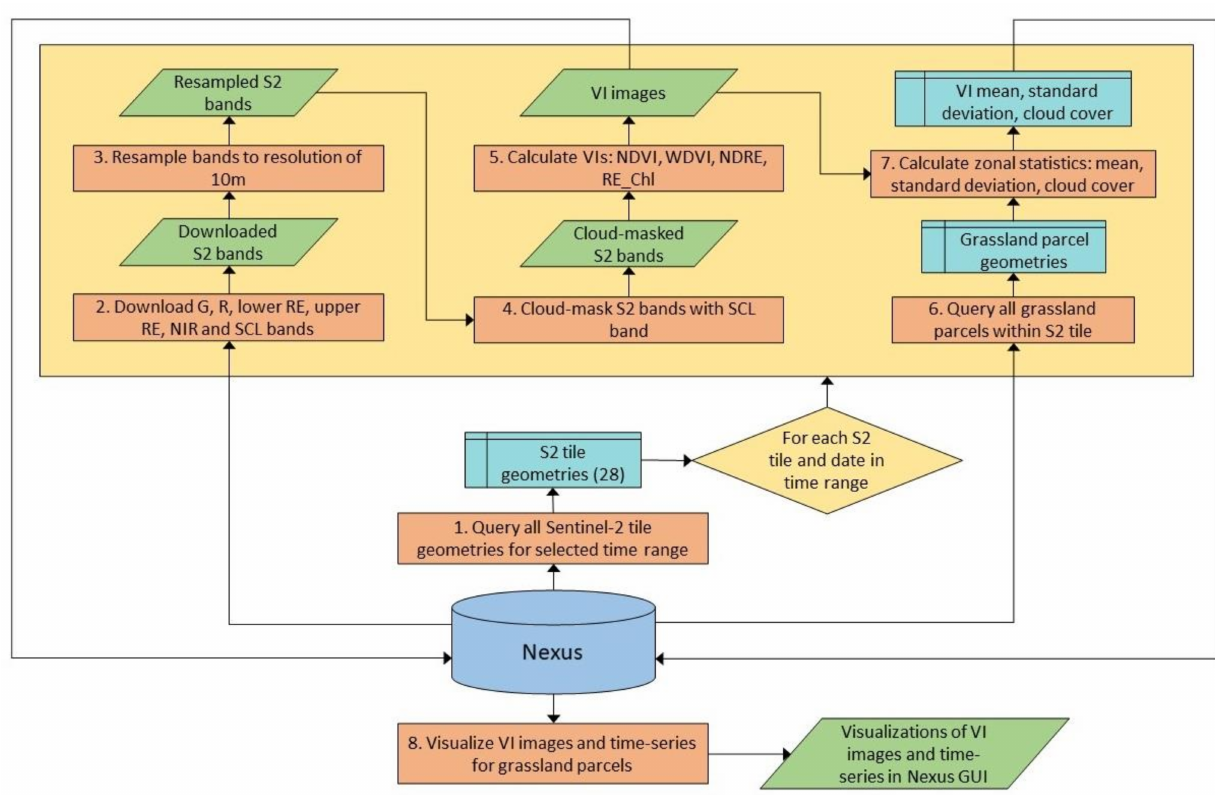
Figure 2. Flowchart containing processes for querying, harvesting, pre-processing, uploading, and visualizing Sentinel-2 (S2) data and vegetation indices (VI) for each S2 tile of 100 × 100 km 2 and date in time range, as part of the Sen2Grass system, with the Nexus server as a central geodatabase. Table 1. Most important field names including data types of the raster and plant_cover tables (respectively containing metadata about Sentinel-2 and parcel data) stored in the Nexus database, used as information in SQL statements to be able to access the actual and corresponding datasets. Raster Table Plant_Cover